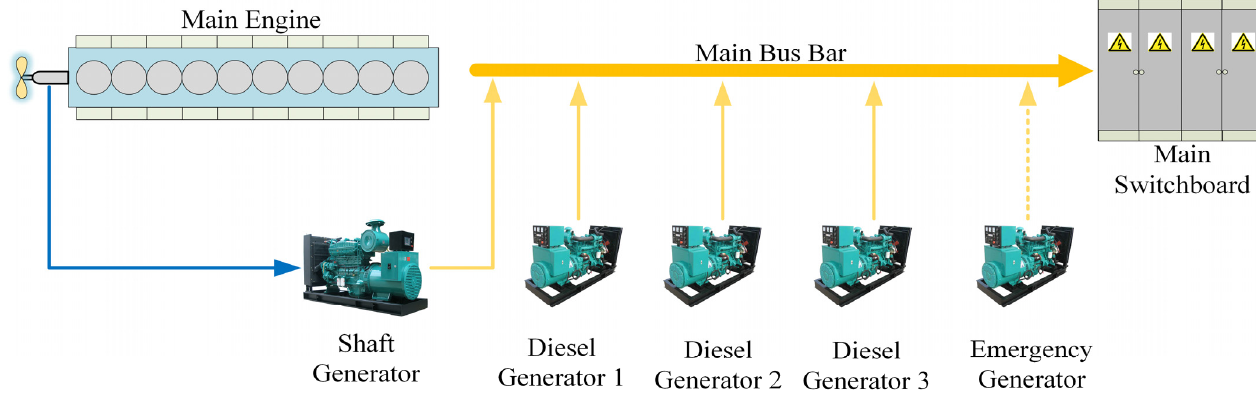
Figure 2. A general illustration of the ship’s microgrid.